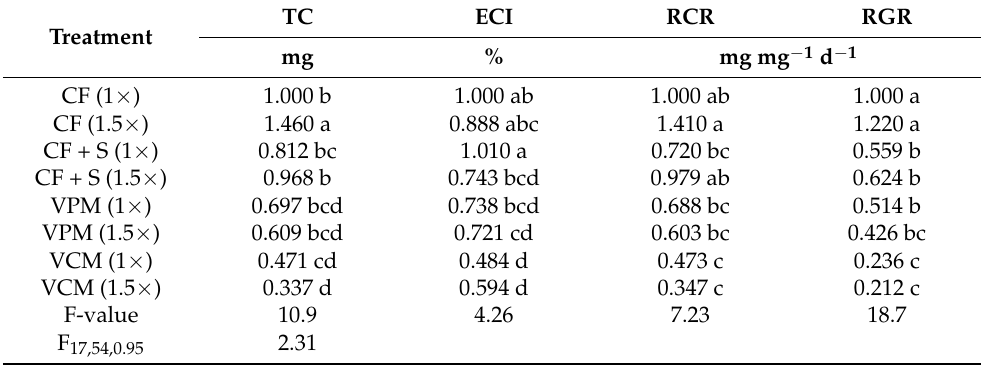
Figure 3. The relationship between intake nitrogen weight (x) and weight increase (y) in Spodoptera litura larvae in the short-term feeding trial. (The meanings of the codes are the same as in Table 2.) Table 6. The relative nutritional indexes 1,2 of Spodoptera litura larvae in the short-term feeding experiment.